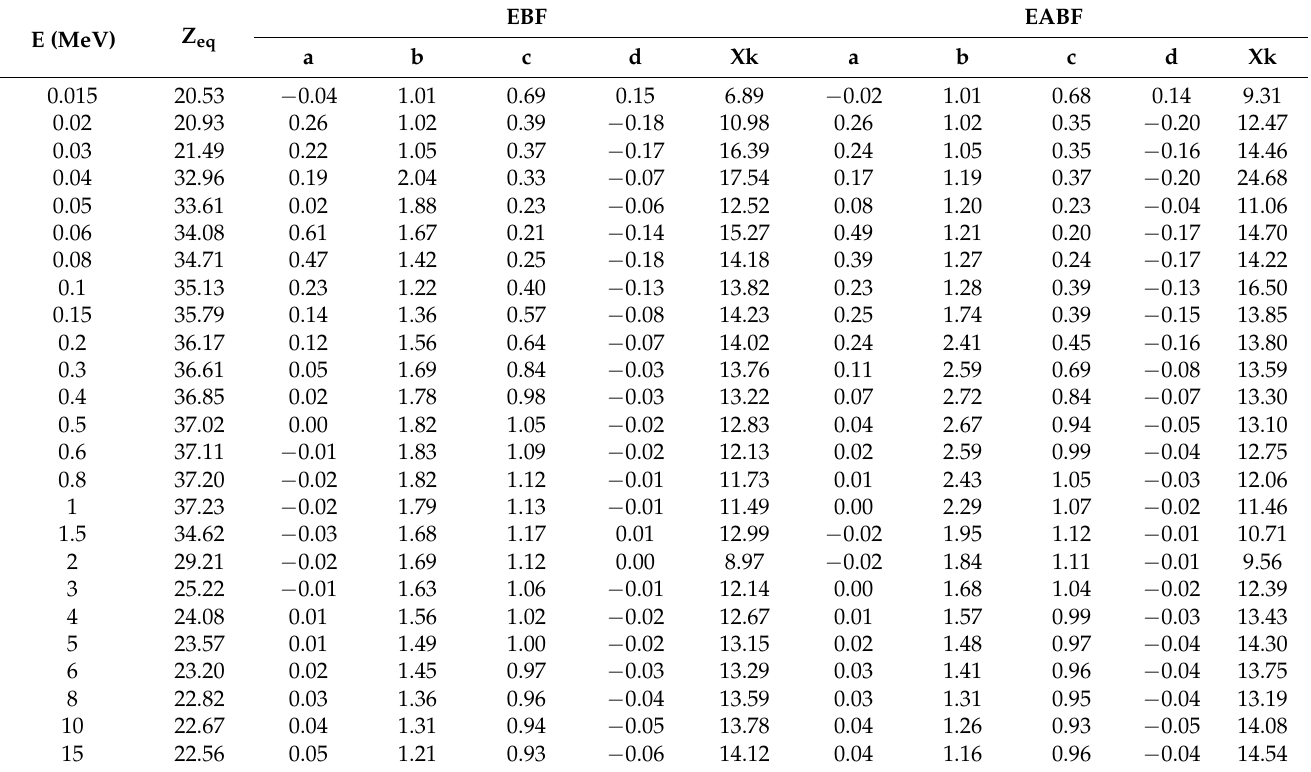
Table 4. The GP fitting parameters for the TALBi5 sample at various gamma